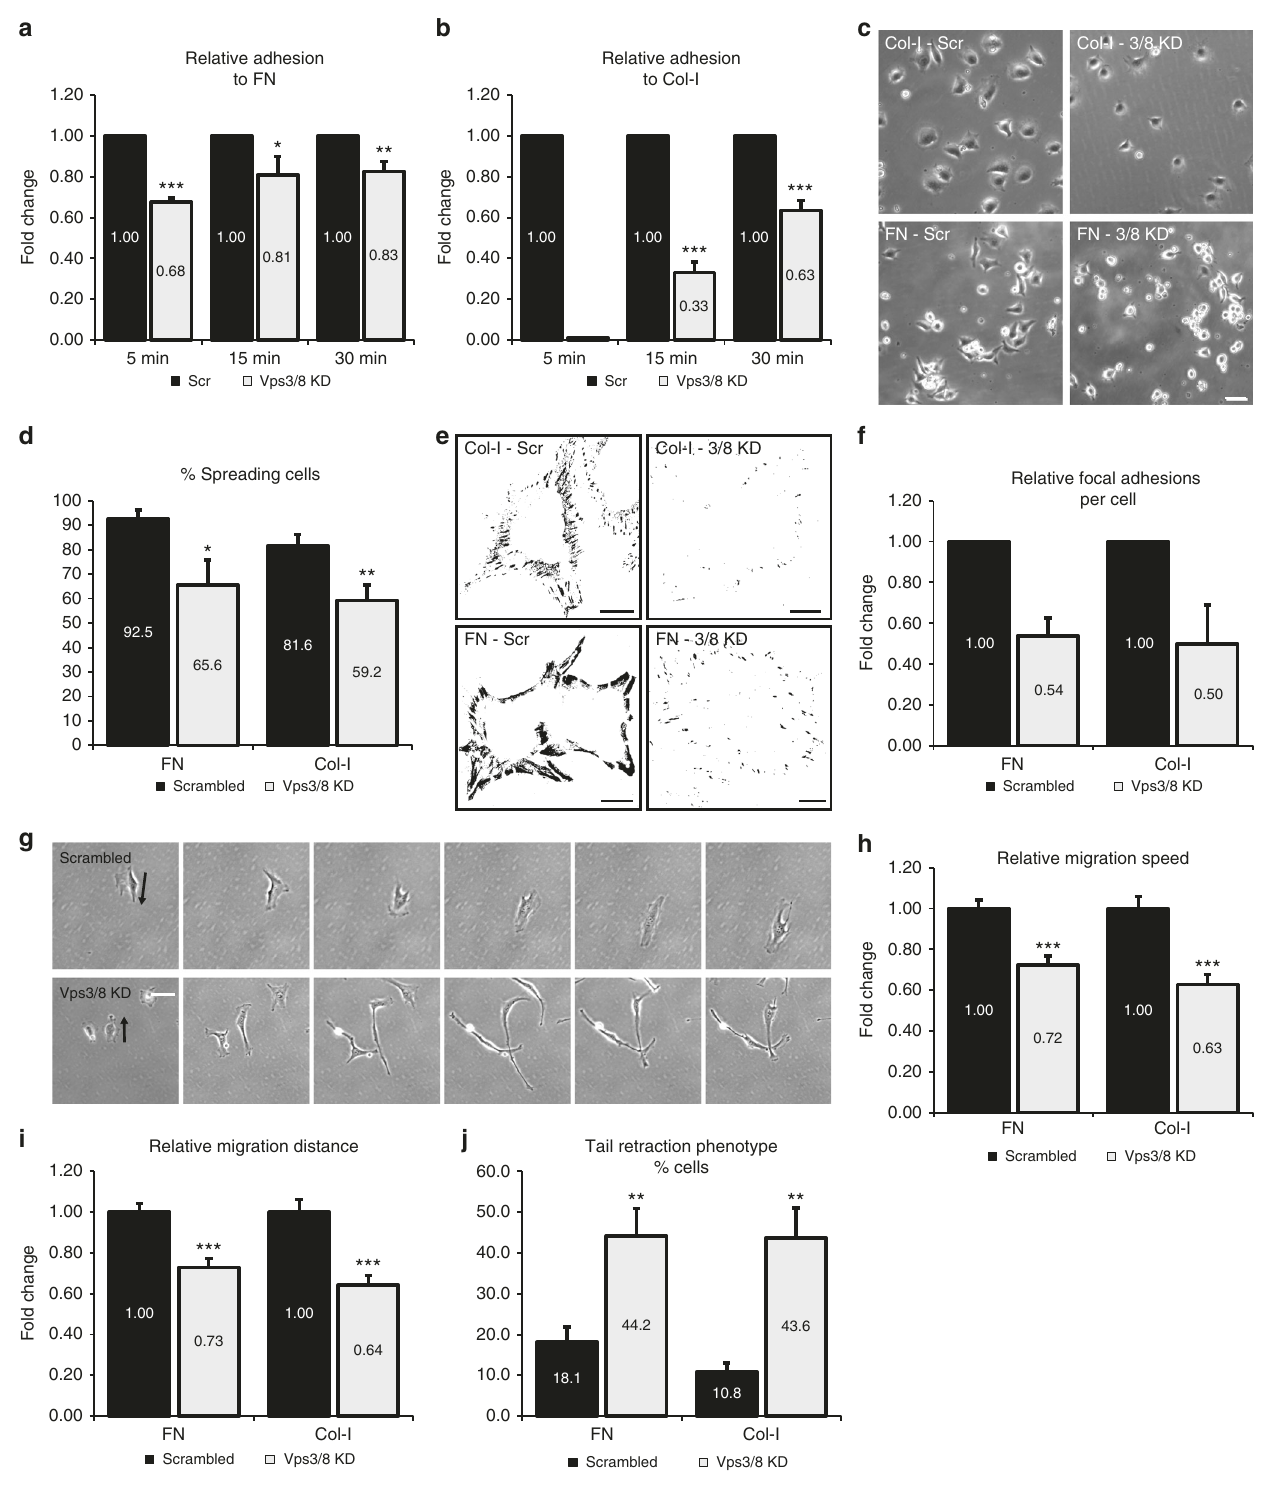
Fig. 5 Vps3 and Vps8 regulate β 1 integrin-dependent cell adhesion and migration. a , b Cells knocked down for Vps3/8 show a decreased capability to attach to FN ( a ) or Col-I ( b ). Error bars indicate SD. c HeLa cells knocked down for Vps3/8 show decreased spreading compared to the control cells 2 h after seeding on Col-I- or FN-coated surfaces. Bar, 100 µ m. d Quanti fi cation of triplicate experiments of c . Error bars represent the SD. e Background- subtracted and thresholded confocal images of HeLa cells knocked down for Vps3/8 and stained with rabbit anti-vinculin. Knockdown cells show a reduction in the number of FAs per cell both on Col-I and FN. Bar, 10 µ m. f Quanti fi cation of triplicate experiments of e . g Time-lapse microscopy of HeLa cells knocked down for Vps3/8 (FN condition, arrows indicate direction of migration) show defects in mean migration speed. Bar, 100 µ m. Relative migration speed ( h ) and mean migration distance ( i ) on both Col-I and FN are reduced. Error bars represent the standard error of the mean (SEM). j The percentage of cells showing an elongated tail during cell migration increases signi fi cantly in knockdown cells on both Col-I and FN. Error bars represent SD. ns = P > 0.05, * P ≤ 0.05, ** P ≤ 0.01, *** P ≤ 0.001 calculated using Student ’ s t